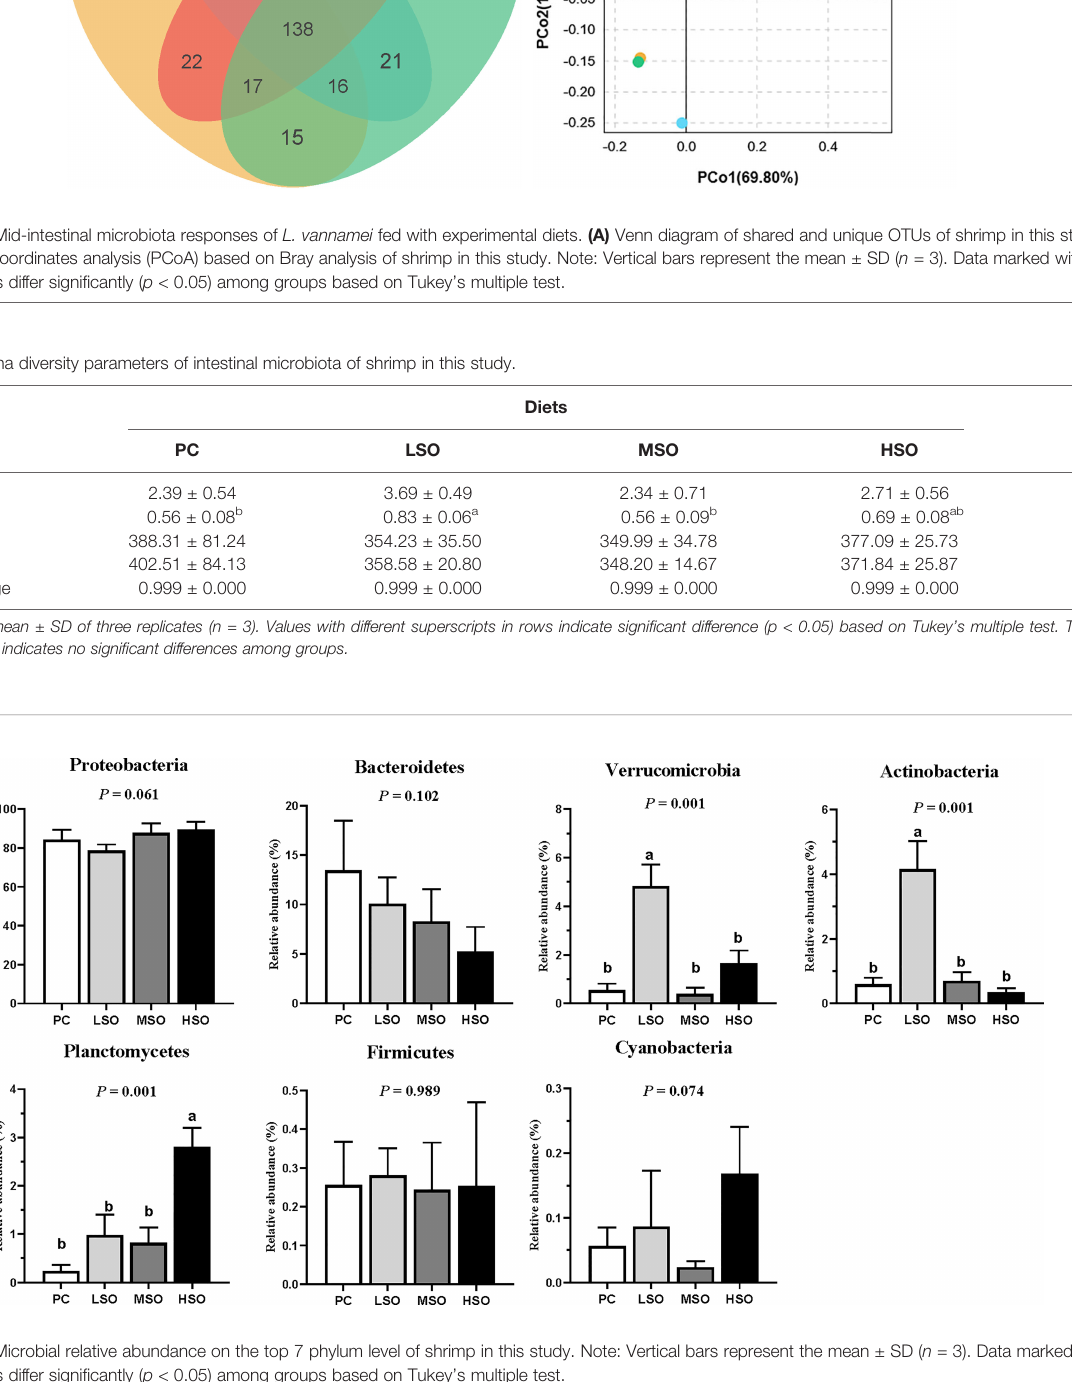
FIGURE 5 | Microbial relative abundance on the top 7 phylum level of shrimp in this study. Note: Vertical bars represent the mean ± SD ( n = 3). Data marked with different letters differ signi fi cantly ( p < 0.05) among groups based on Tukey ’ s multiple test.